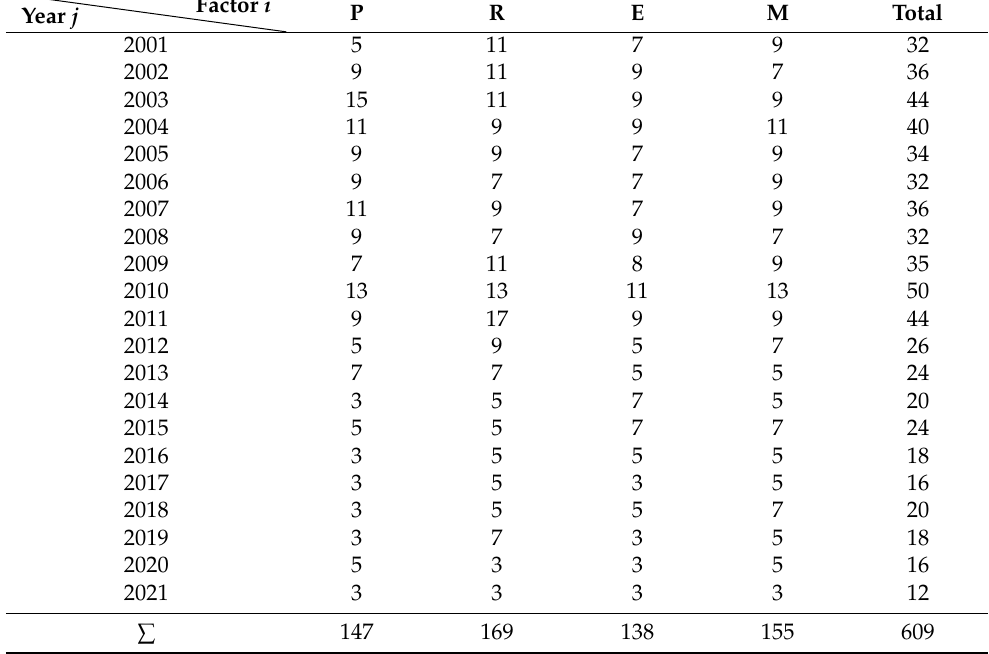
Table 1. Initial statistics of traditional ship navigation